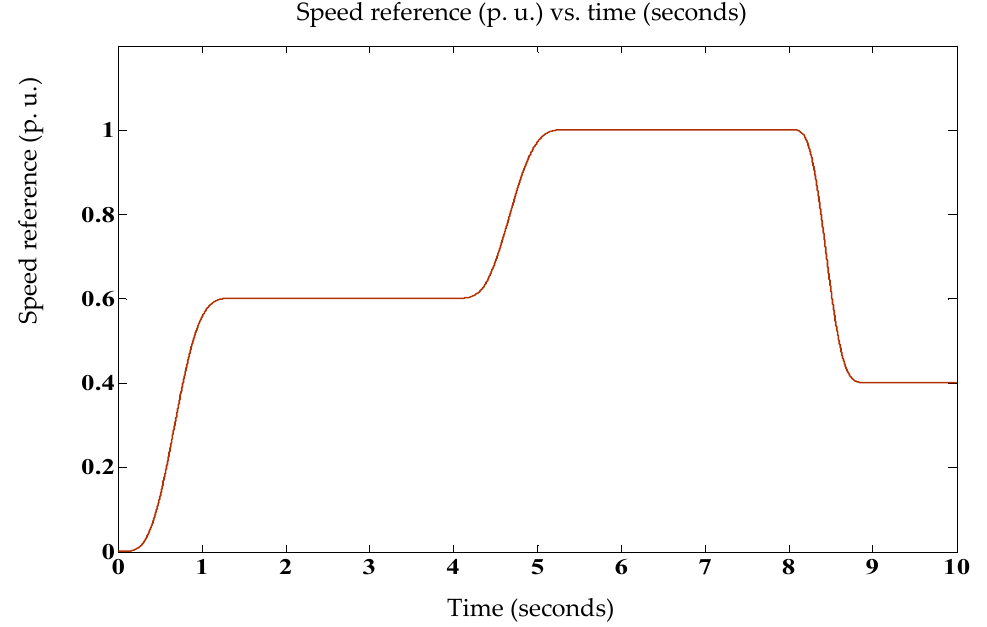
Figure 13. Speed reference profile: Load torque proportional to speed T L α ω .